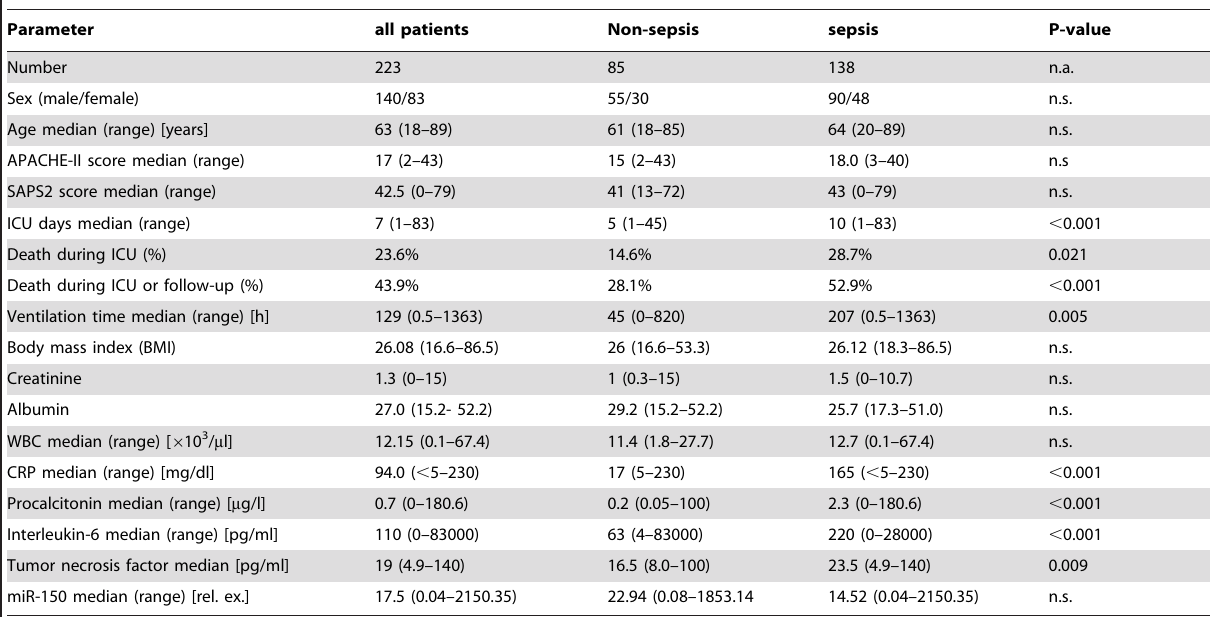
Table 1. Baseline patient characteristics.